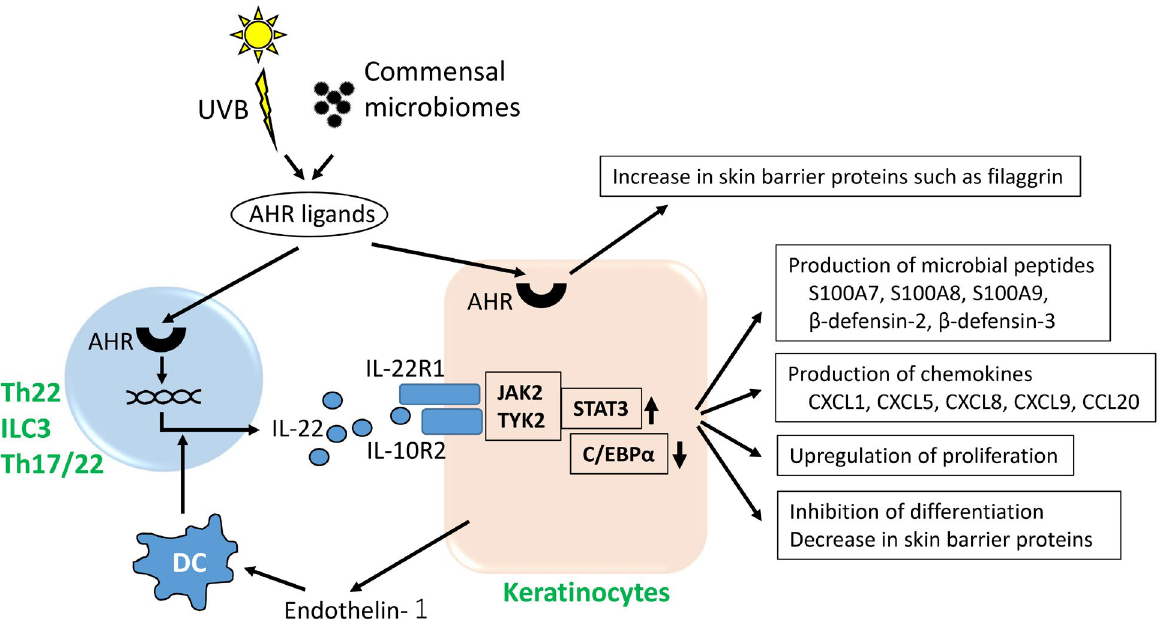
Figure 1. AHR, IL-22 and keratinocytes. IL-22 is produced by Th22 cells, Th17/22 cells and ILC3. UVB irradiation and commensal microbiomes generate various AHR ligands. AHR activation upregulates gene expression of IL-22 and also stimulates keratinocytes to increase production of barrier-related proteins such as filaggrin. Dendritic cells (DCs) treated with keratinocyte- derived endothelin-1 induce T cells to produce IL-22. Keratinocytes express IL-22R1 and IL-10R2 complex. IL-22 binds the IL- 22R1/IL-10R2 heterodimer, activates the JAK2/TYK2 and STAT3 pathway and inhibits the activity of CCAAT/enhancer binding protein α (C/EBPα), stimulating keratinocytes to produce microbial peptides and chemokines. IL-22 upregulates proliferation and inhibits differentiation of